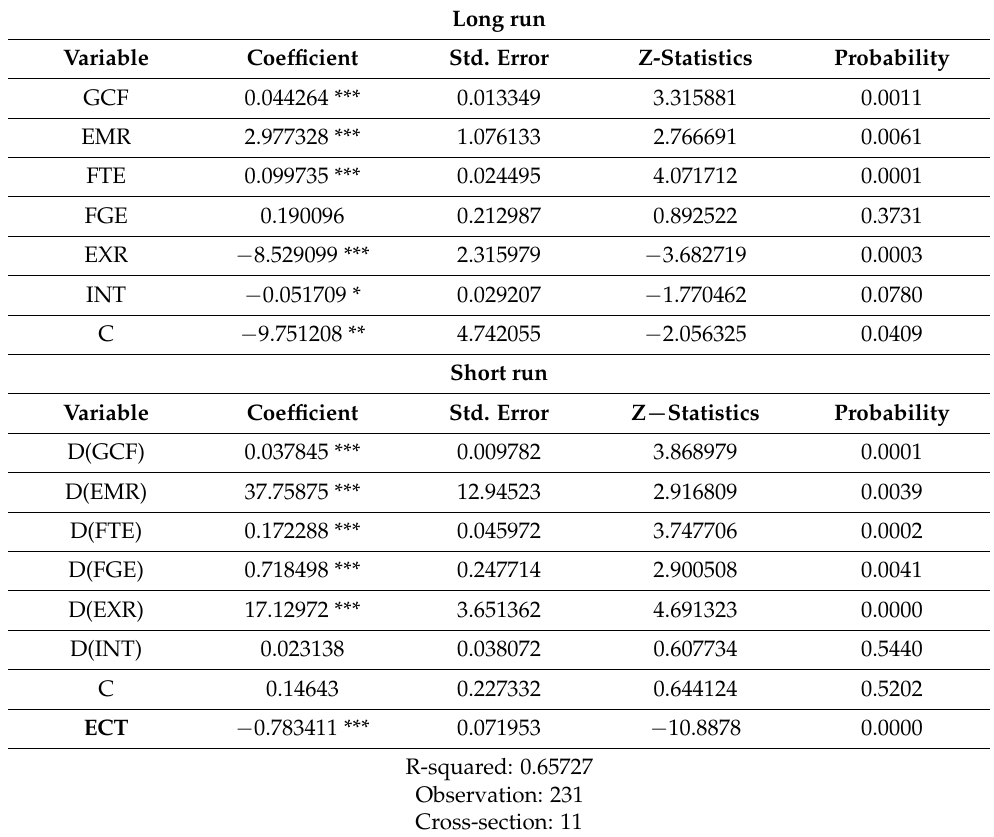
Table 4. CS-ARDL Estimation Result for the Productivity